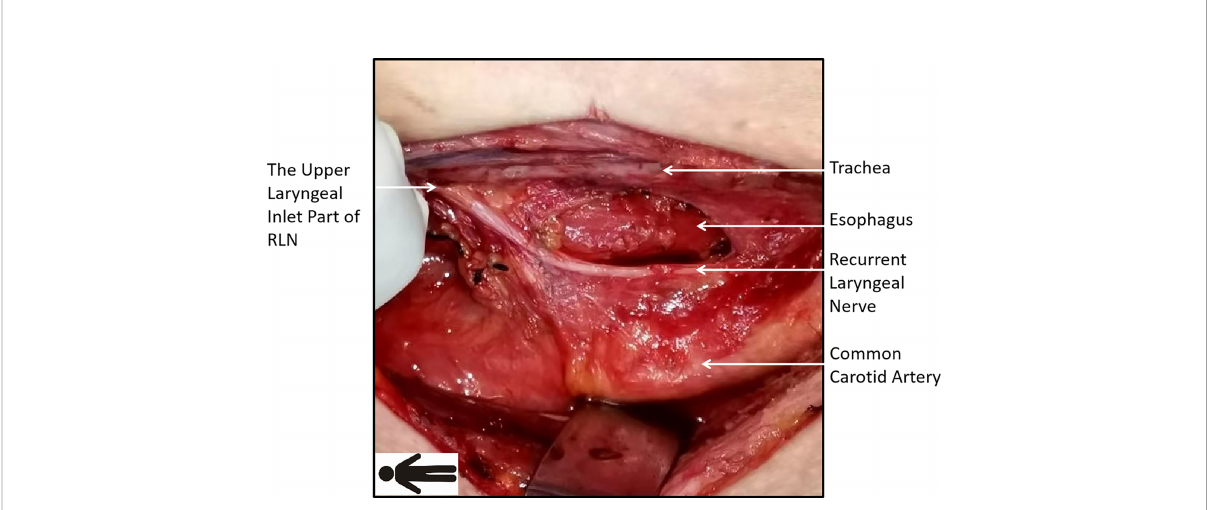
FIGURE 1 Course of the right recurrent laryngeal nerve (RLN): the right RLN runs obliquely with its inferior side closer to the common carotid artery. Level VIb, limited by the nerve and trachea, is shaped as a triangle with its top on the upper